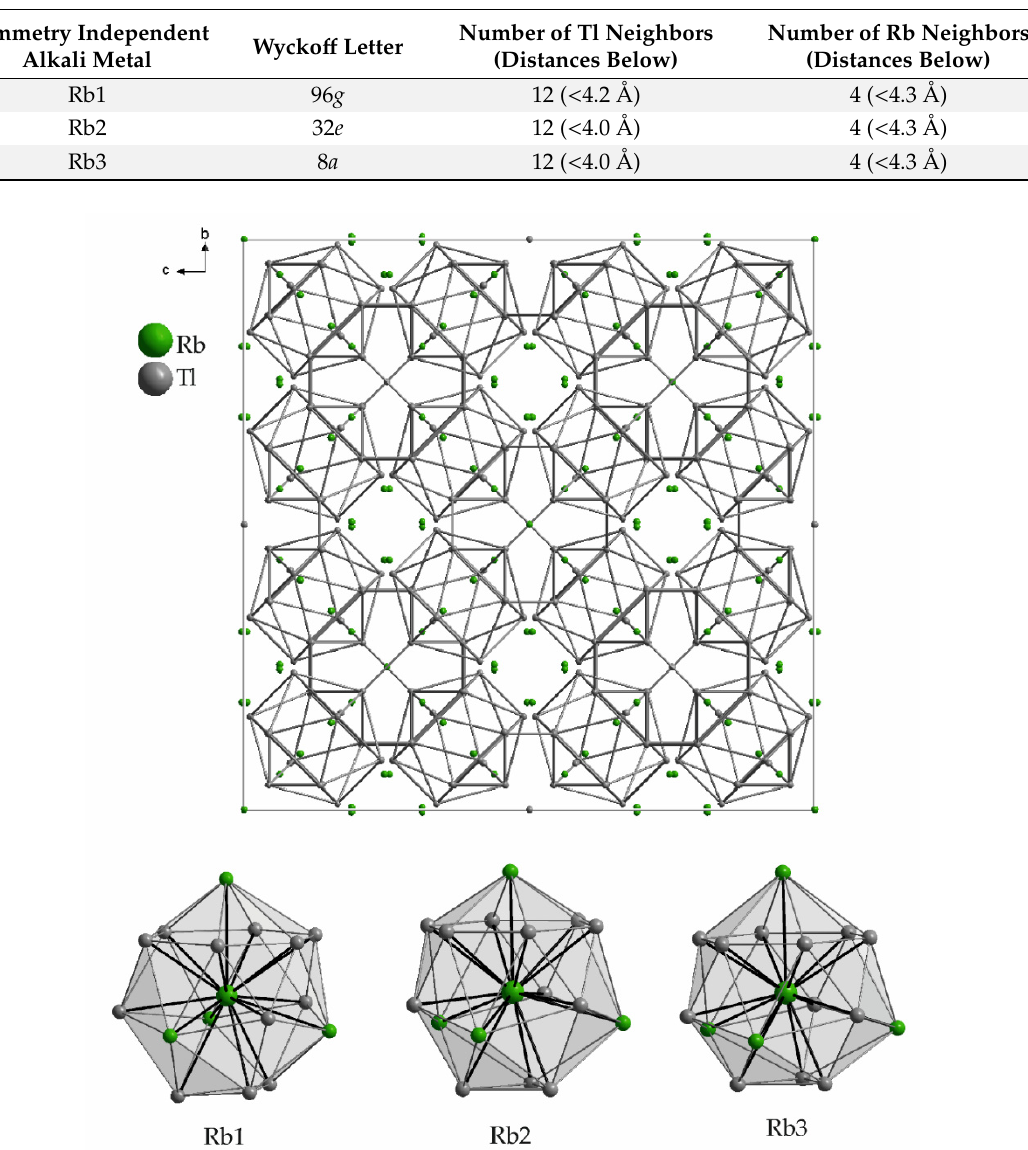
Figure 4. Unit cell and surroundings of the three symmetry inequivalent potassium positions in Rb 17 Tl 41 . The corresponding range of distances to the adjacent atoms as well as the Wyckoff letters are given in Table 3.